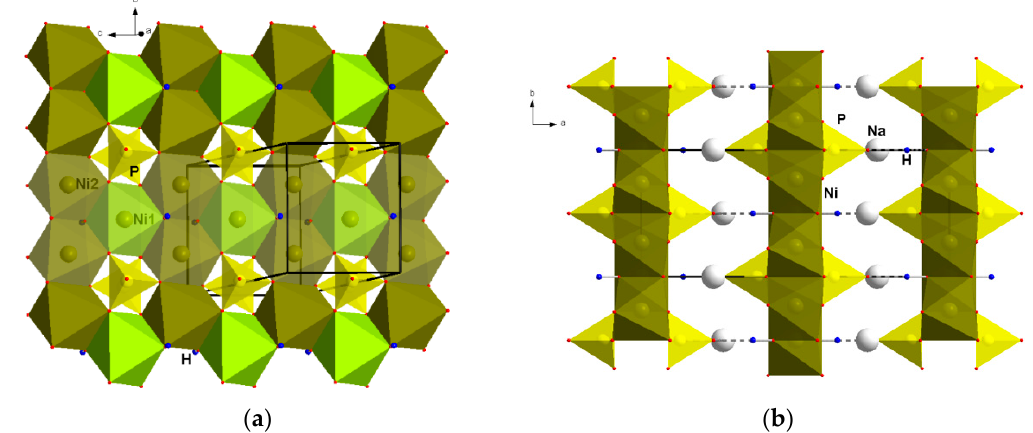
Figure 7. The crystal structure of Na 2 Ni 3 (OH) 2 [PO 4 ] 2 in [101] ( a ) and [001] ( b ) projections.